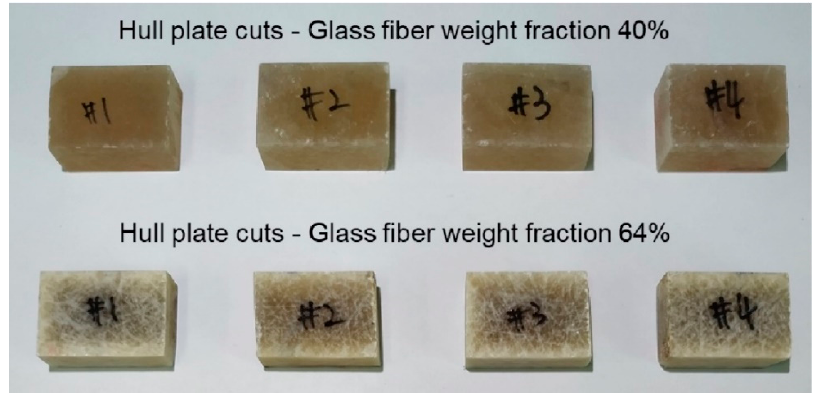
Figure 5. Specimens cut from two hull plates.